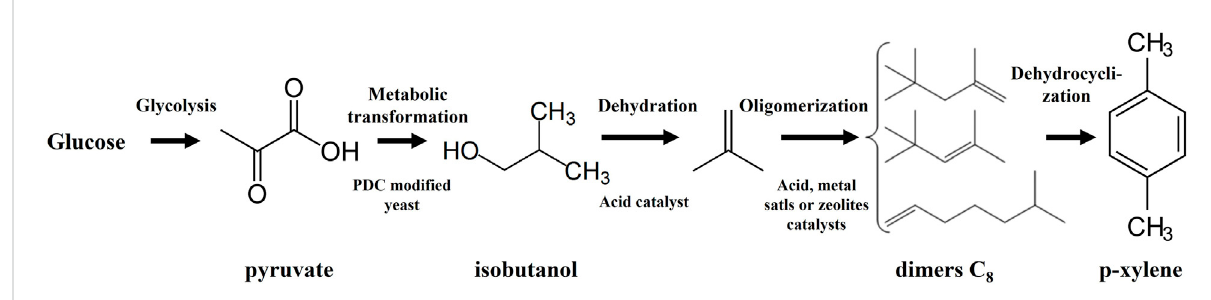
FIGURE 6 Routes of conversion of glucose to isobutanol then to p-xylene (adapted from Volanti et al.,